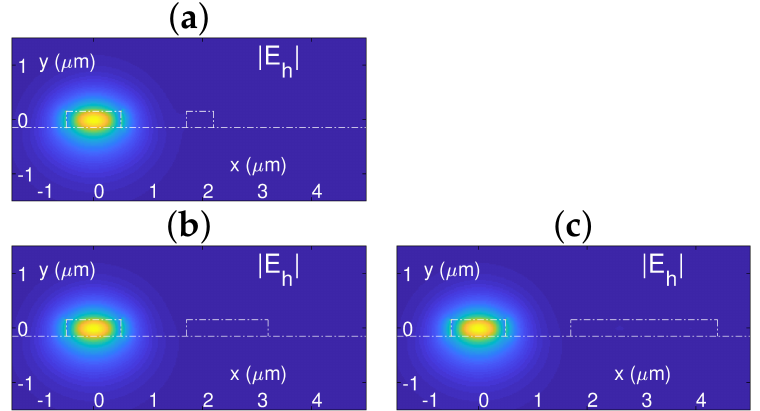
Figure 4. Amplitudes of the horizontal main field components of the TE modes propagating in the straight coupled asymmetric structure of Figure 2. The plots correspond to the respective modal sheets of Figure 3, each of them lying on the plane defined by the effective index of the isolated main waveguide (principal modes). Plots ( a – c ) are for the same value of s = 1.7 µ m and respective values of w e of 0.5, 1.5 and 2.7 µ m. The waveguide boundaries are outlined with a white dashed